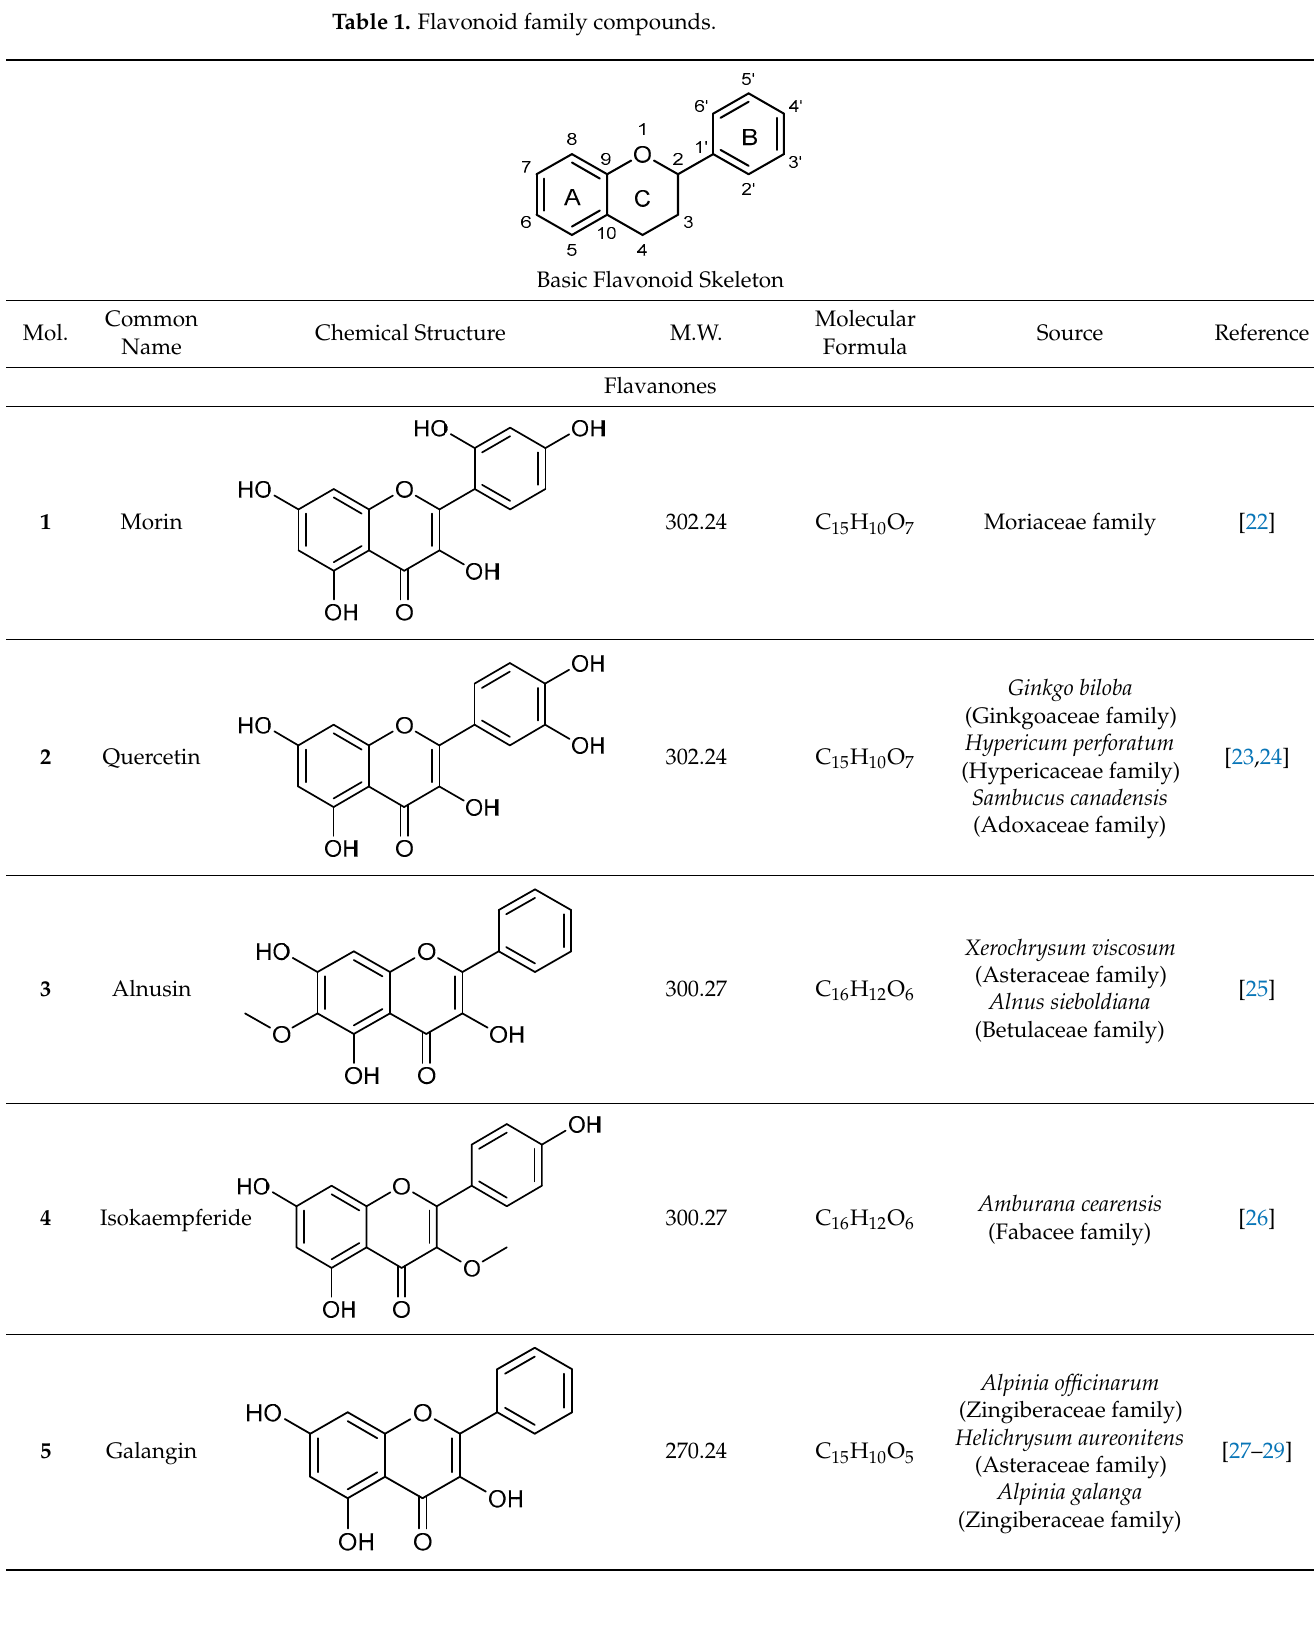
Table 1. Flavonoid family compounds.